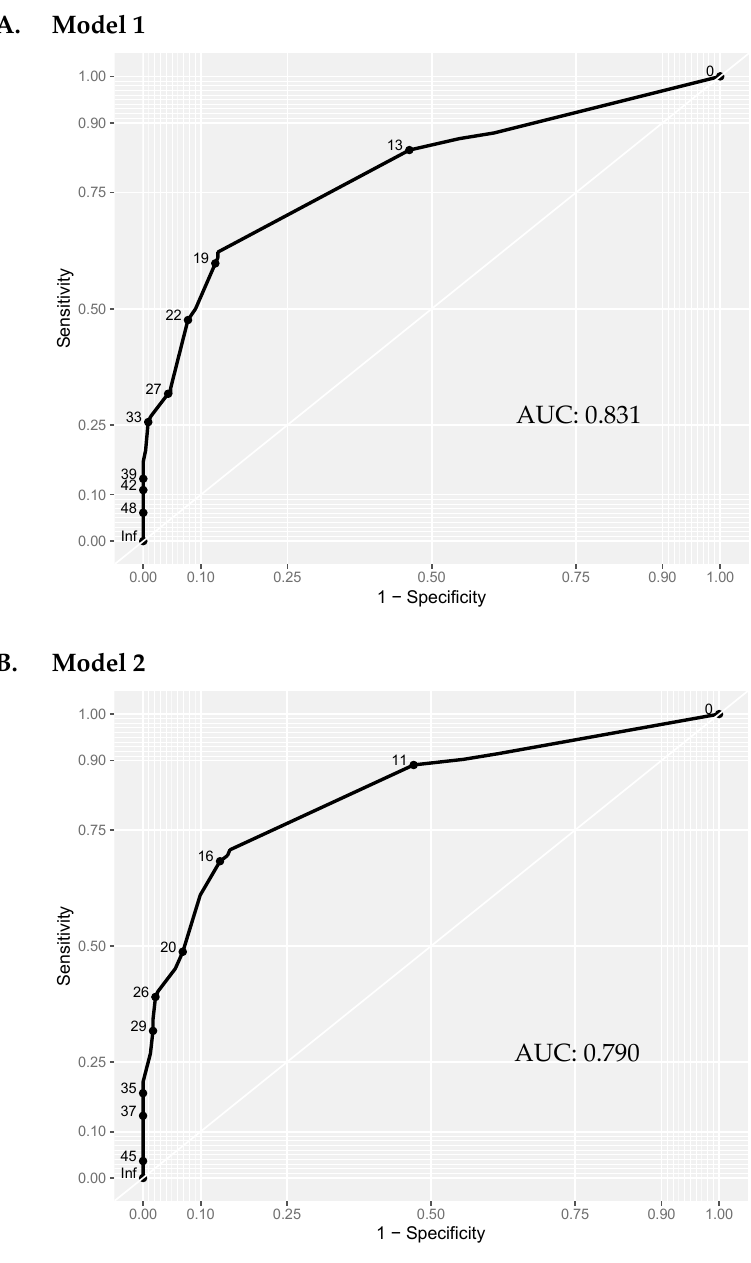
Figure 1. ROC curve analysis of the multivariate prediction models. Model 1: including self-dynamisation. Model 2: excluding self-dynamisation. The discriminatory capability was similar in model 1 (including self-dynamisation; AUC = 0.831), and model 2 (excluding self-dynamisation; AUC = 0.790) was comparable. AUC: Area Under the Curve.